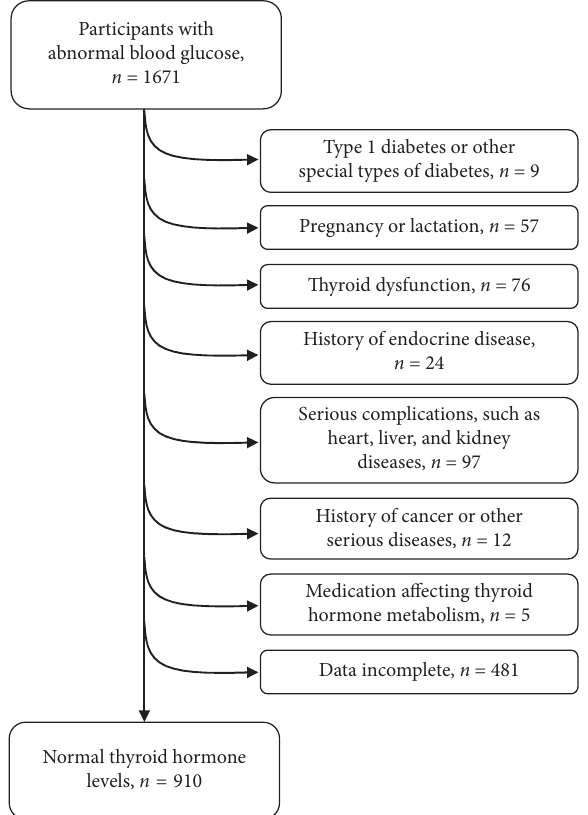
Figure 1: Flowchart of participant enrolment based on eligibility